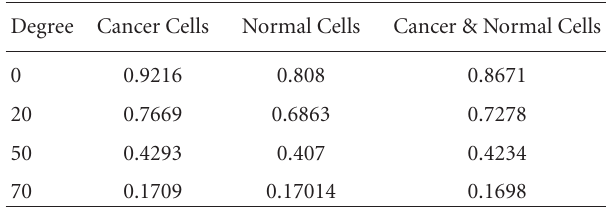
Table 1: Electrical parameters used [9, 10]. Table 2: Nuclear membrane potential of tumor and normal